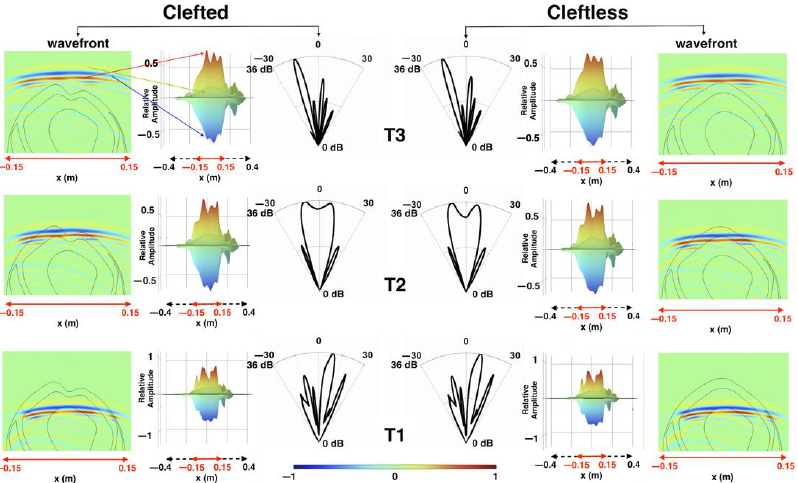
Figure 8. Comparison of sound propagation through the forehead cleft at three instances in time between the “clefted” case and “cleftless” case. T1: before the sound waves reached the forehead cleft, T2: when the sound waves were passing through the forehead cleft, T3: when the sound waves left the forehead cleft. The color bar shows the scale of relative sound pressure. The sound pressure was relative to the highest sound pressure value at T3. The arrows show the corresponding 3D height expression of the click wavefront. The height expression introduces 3D height to the 2D wavefront plots: the red curve of >0.5 amplitude illustrates the amplitude along the dark red wavefront in the wavefront plot (see red arrow); the blue curve with negative amplitudes corresponds to the dark blue wavefront (see blue arrow); the yellow height expression corresponds to the leading, weaker, positive wavefront (see yellow arrow).